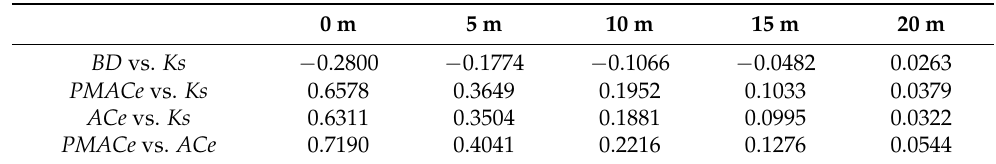
Table 4. Cross-correlation coefficients computed at different lags (0, 5, 10, 15, 20 m) between BD , Ks and the two capacitive indicators PMACe and ACe